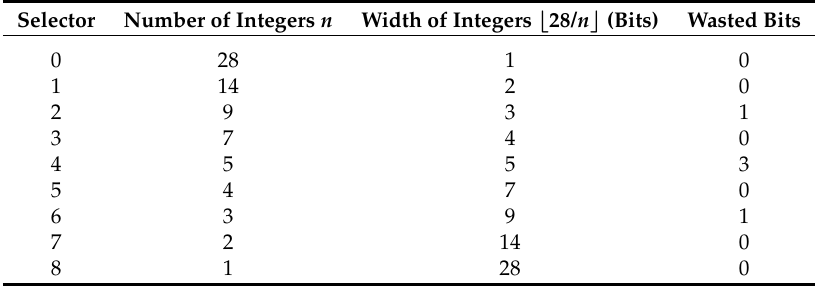
Table 3. Nine different ways of encoding numbers in the 28-bit packing space in Simple9.